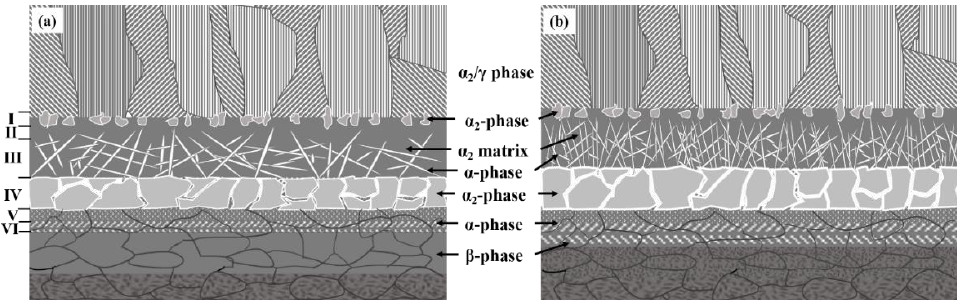
Figure 11. The microstructure schematic of joints: ( a ) as-welded; ( b ) post-welded heat treatment.